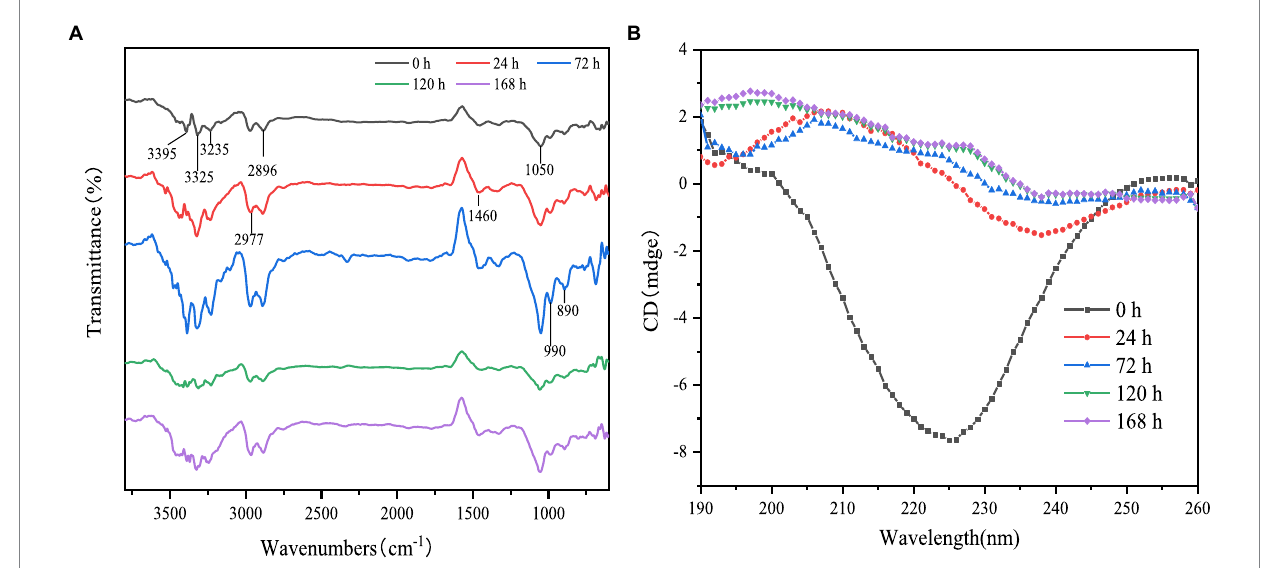
FIGURE 2 Infrared spectrum and circular dichrography of gluten at different fermentation times. (A) FT-IR spectra of gluten at different times of fermentation. (B) Circular dichroism of gluten at different times of